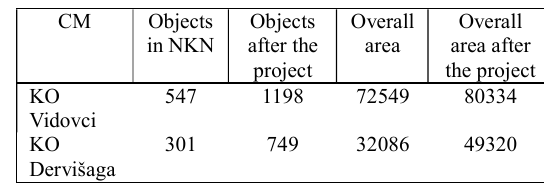
Table 2 Results in Požega's cadastral municipalities with